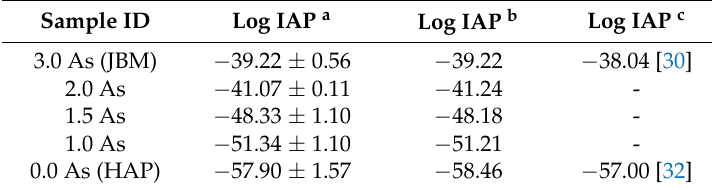
Figure 14. Nonlinear regression of experimentally determined ion activity products logIAP vs. temperature T for synthetic JBM–HAP solid solution series. The error bars represent two standard deviations of the average calculated from three distinct experimental results at steady state. R 2 represents the coefficient of determination. A, B, and D are the parameters in Equation (7). Table 5. Comparison of solubility products logKsp calculated from the experiment a , determined from a nonlinear regression b , and reported in the literature c for JBM–HAP solid solution